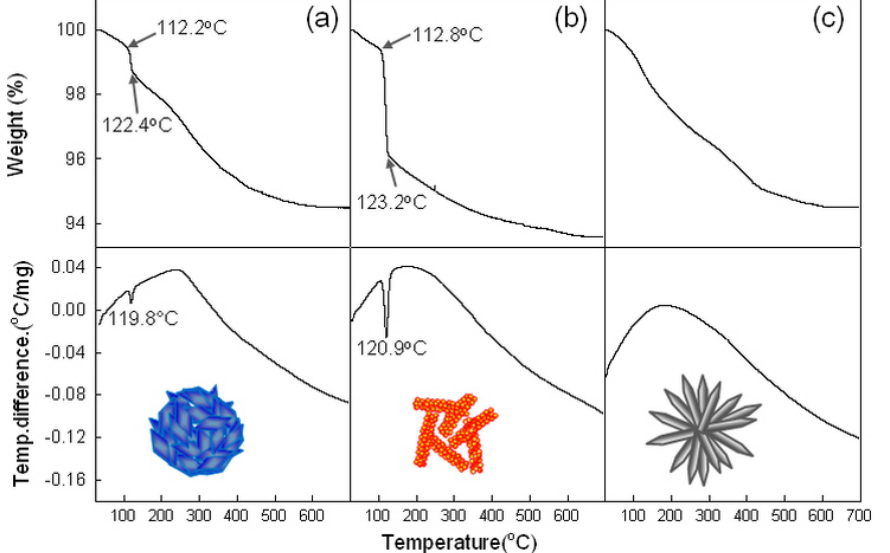
Figure 5. Differential scanning calorimetry (DSC) and thermogravimetric analysis (TGA)curves of ( a ) H-NS precursors; ( b ) NR precursors; and ( c ) H-NR